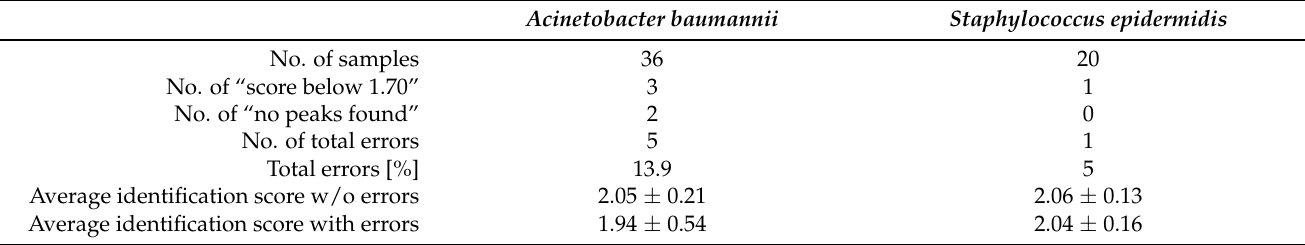
Table 2. Identification process